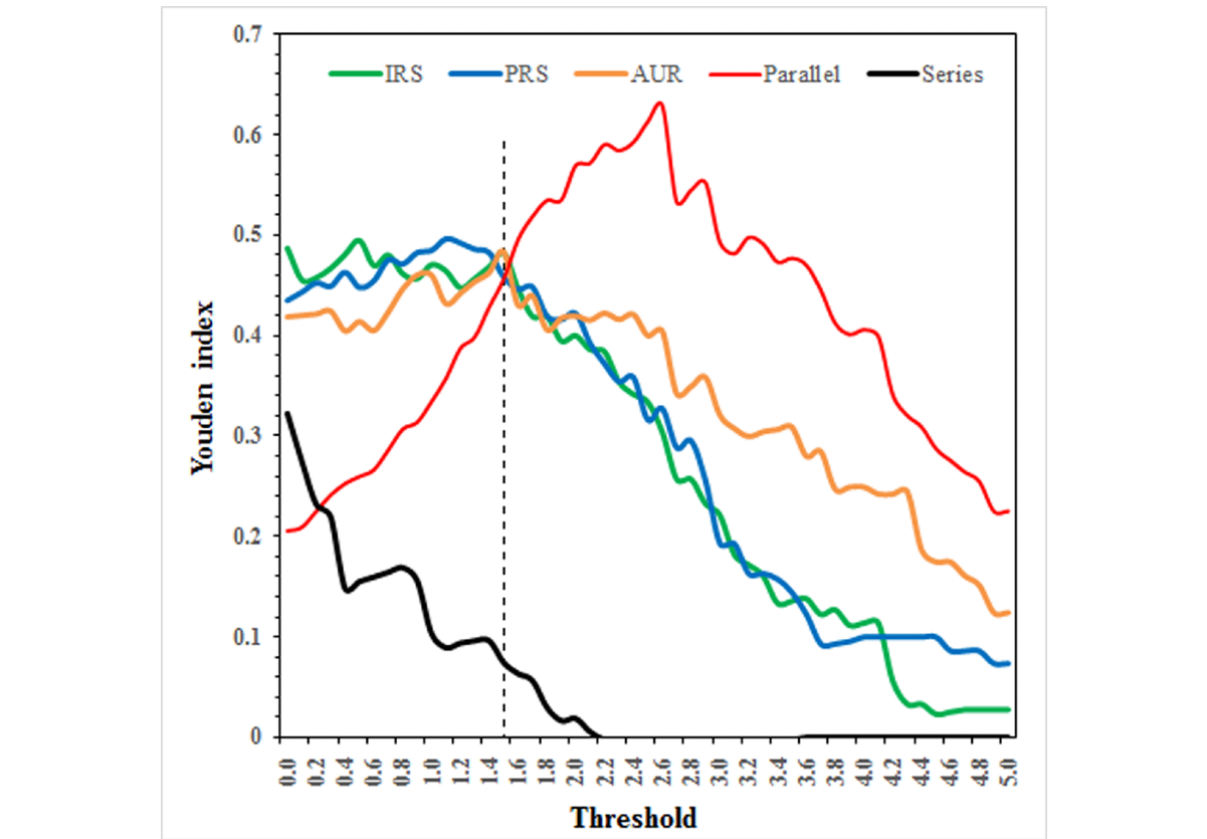
Figure 4. The curves of Youden index varied with thresholds of Shewhart detection model. AUR: Antibiotic utilization rate in combination; IRS: Inspection rate of bacterial specimens; PRS: Positive rate of bacterial